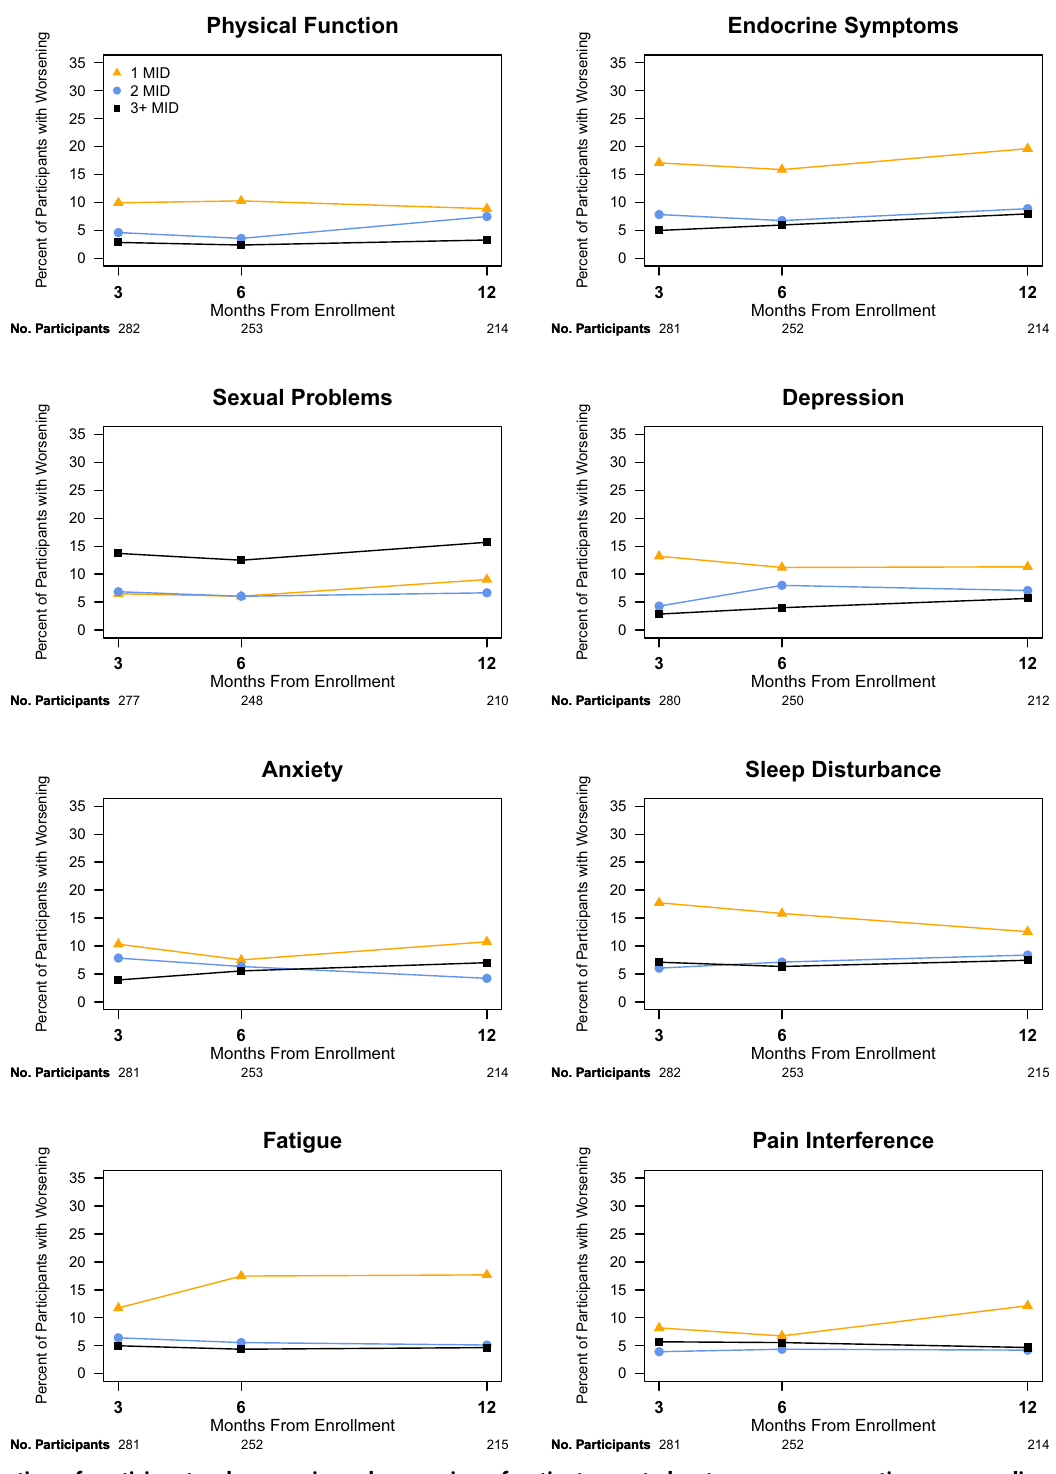
Fig. 3 Proportion of participants who experienced worsening of patient-reported outcome scores meeting or exceeding the minimal important difference at 3, 6, and 12 months. Line graphs display percentage of participants with worsening of PRO scores compared to baseline at 3, 6, and 12 months after enrollment. Worsening of PRO scores is categorized as at least the MID but less than twice the MID, at least twice the MID but less than three times the MID and at least three times the MID for each measure. Only participants with baseline values and at least one follow-up measure are included. The percentage of participants whose PRO scores worsened by less than the MID (i.e. who experienced improvement, no change or worsening less than the MID) are not displayed. The MID was considered to be 4 points for the physical function, depression, anxiety, sleep disturbance, fatigue, and pain interference measures; 8 points for the sexual problems measure; and 5 points for the endocrine symptoms measure. MID minimal important difference, 1 MID at least the MID but less than twice the MID, 2 MID twice the MID but less than three times the MID, 3 + MID at least three times the MID, PRO patient-reported